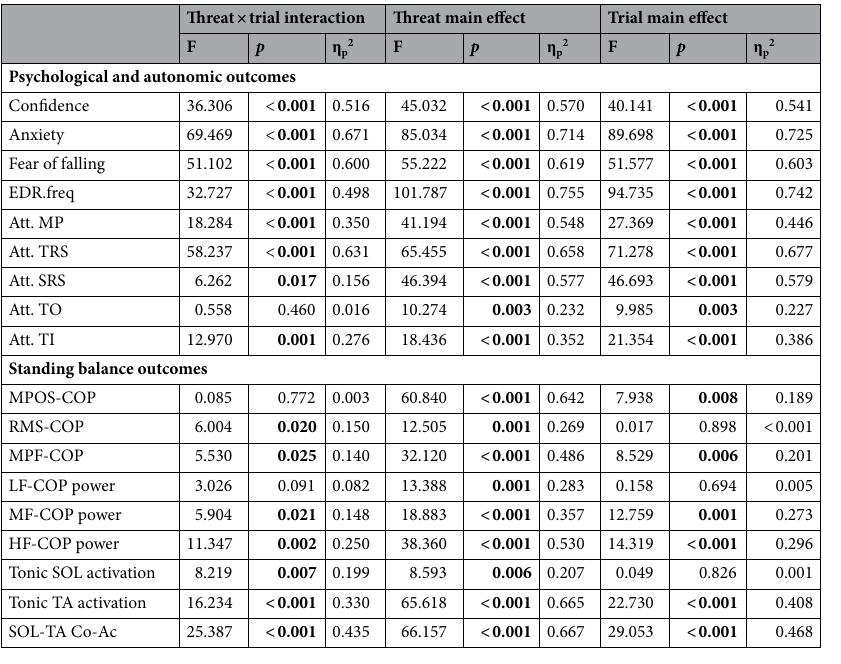
Table 2. Two-way repeated-measures ANOVAs (threat: LOW vs. HIGH; trial: pre vs. post) examining within-session habituation of self-report, autonomic, and standing balance outcomes at visit 1. EDR.freq: non-specific electrodermal response frequency; Att.: attention toward; MP: movement processes; TRS: threat- related stimuli; SRS: self-regulatory strategies; TO: task objectives; TI: task-irrelevant information; MPOS: mean position; RMS: root mean square; MPF: mean power frequency; LF: low-frequency (0–0.05 Hz); MF: medium-frequency (0.5–1.8 Hz); HF: high-frequency (1.8–5 Hz); SOL: soleus; TA: tibialis anterior; Co-Ac: coactivation. Significant p-values (<0.05) are